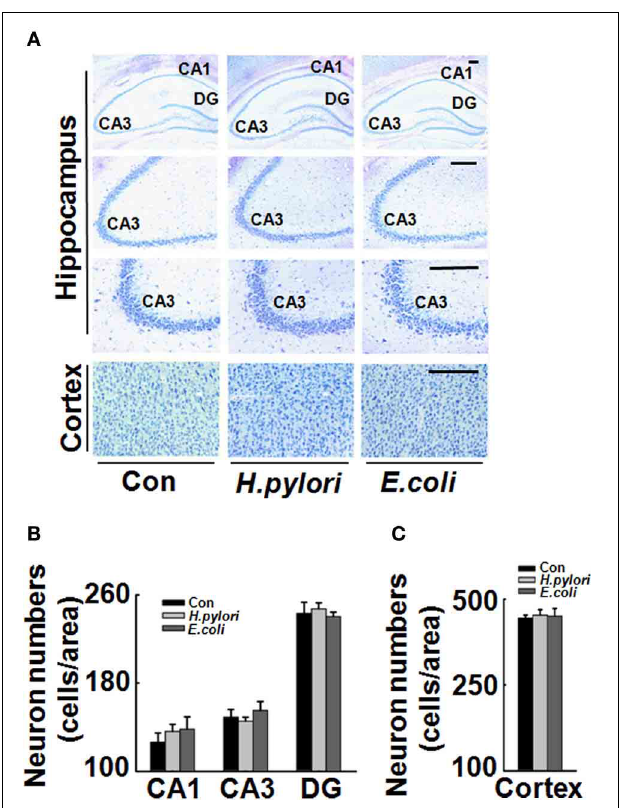
FIGURE 2 | Intraperitoneal injection H. pylori filtrate does not cause neuron death in rat brains. SD rats were intraperitoneally injected with H. pylori filtrate, E.coli filtrate or DMEM/Opti-MEM medium (280 μ l/rat/day) for 7 days as described in Figure 1A . Then the rats were anesthetized and fixed by transcardial perfusion ( n = 3). Neurons in the rat brain were stained by Nissl staining. (A) Representative images from the hippocampus and cortex (Scale bars = 100 μ m). Quantitative analysis of the neuron numbers in CA1, CA3, and DG region of hippocampus (B) and in the cortex (C) showed no difference among different groups.